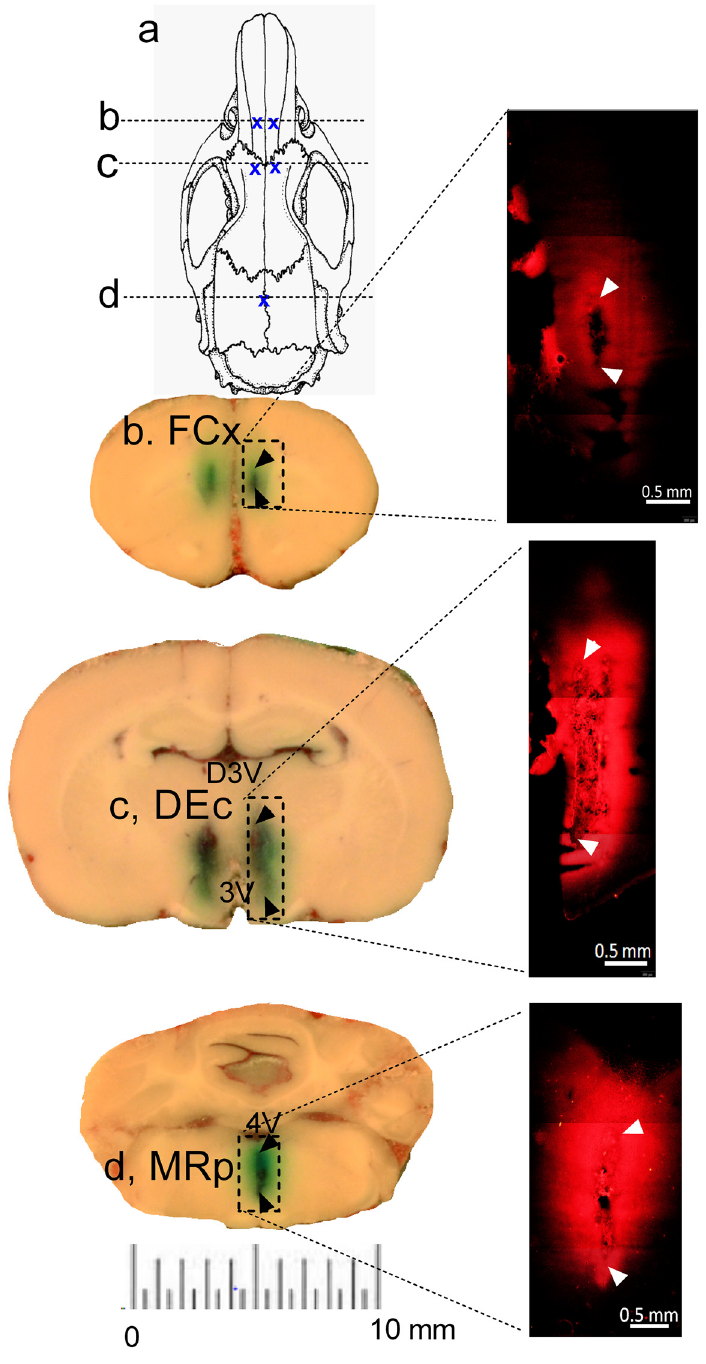
Fig 7. Relationship between intracranial administration and dye diffusion from the delivery site to the surrounding or distant tissue. The route of intracranial administration was reverse microdialysis. The dyes used in this test were fast green and DiI. N = 4 rats/group. a, A diagram illustrates a dorsal view of the location of guide cannulas and dash lines indicate where the brain was sliced. b, Bilateral reverse microdialysis administration of fast green in the FCx. Inset, DiI administration; c, Bilateral reverse microdialysis administration of fast green in the DEc. Inset, DiI; d, Singular reverse microdialysis administration of fast green in the MRp. Inset: DiI